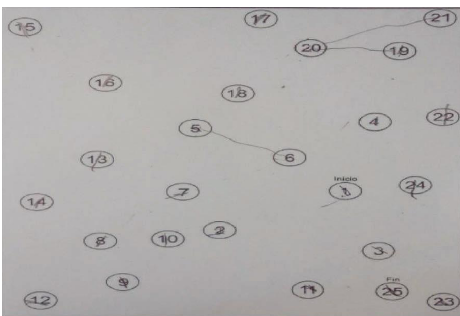
Figure 2: Trail making test (TMT) form A results. Duration: 3 ′ 52 ″ .